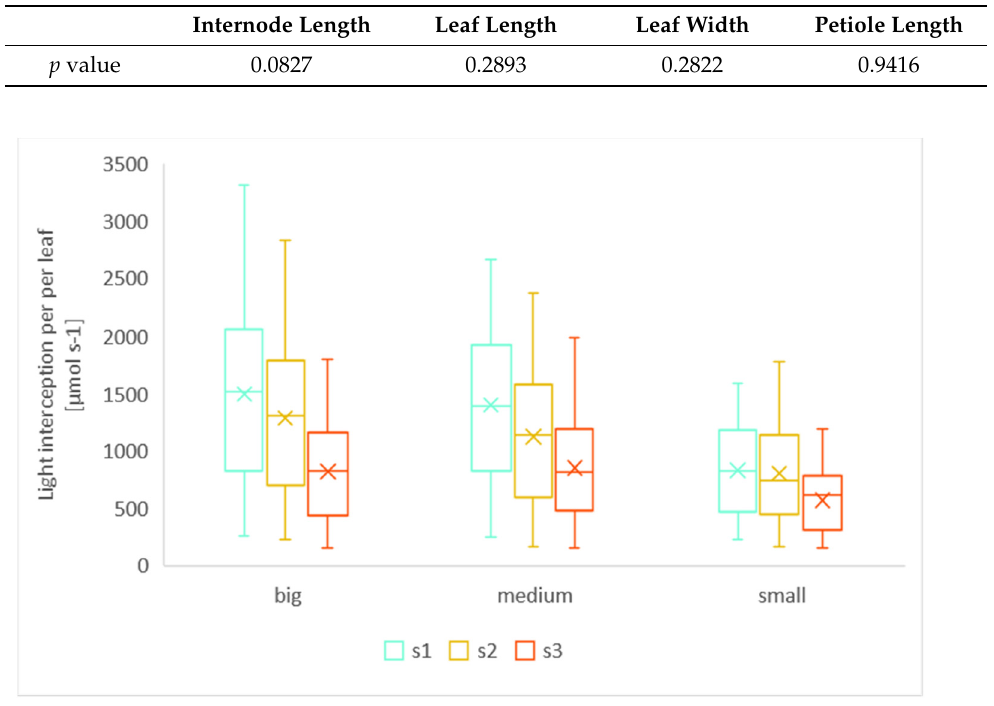
Table A1. p -values in the Kolmogorov–Smirnov Test for the traits with null-hypothesis of a normal distribution.